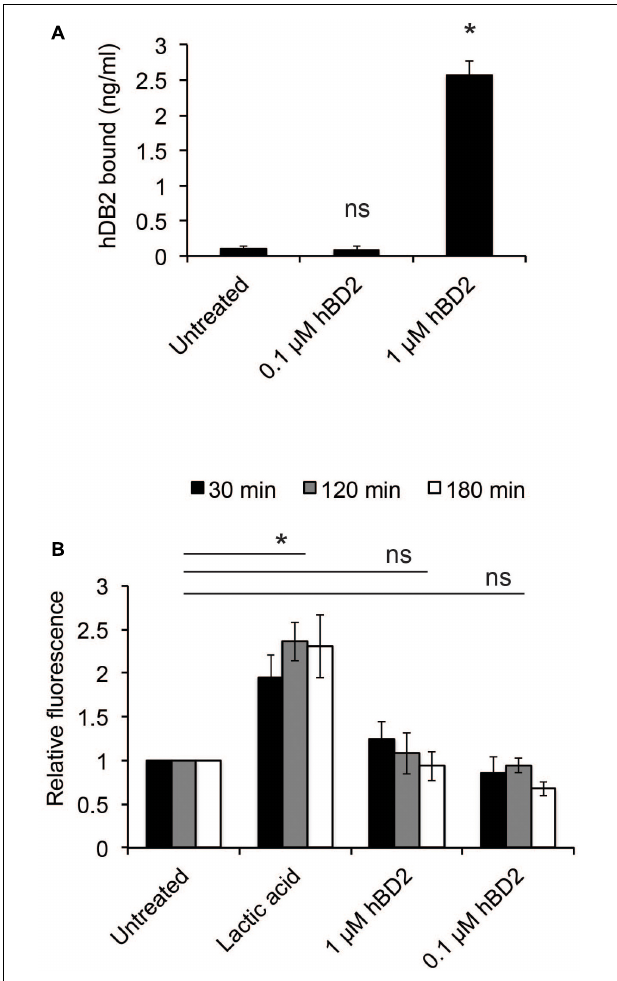
FIGURE 2 | Human beta-defensin 2 binds N. meningitidis and induces membrane permeability. (A) Log-phase bacteria were incubated with hBD2 (0.1 or 1 µ M) for 3 h. Bacteria were washed with PBS, and bound hBD2 was determined by ELISA. The assay was performed in triplicate at least three times. (B) Outer-membrane permeabilization was assessed by NPN fluorescence. Log-phase bacteria were incubated with NPN (10 µ M) and hBD2 (0.1 µ M and 1 µ M) for 3 h. Lactic acid was used as a positive control. Background fluorescence (NPN in the absence of bacteria or hBD2) was subtracted. Values are expressed relative to the untreated control. The assay was performed in duplicate at least three times. Data are represented as the mean values, with error bars representing the standard deviation. Significance was tested against the untreated control. * P < 0.05; ns,